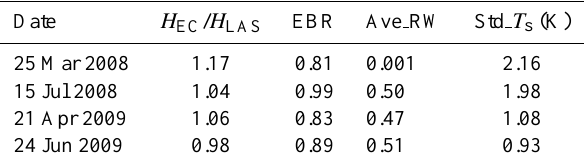
Table 4. Relationships among the differences of the EC and LAS measurements, the energy closure ratio of the EC, the degree of overlap between the source areas of the LAS and EC measurements, and the heterogeneity of the underlying surface at the satellite pass- ing time ( H EC / H LAS : the ratio between the sensible heat fluxes measured by the EC and LAS; EBR: energy balance ratio; Ave RW: the average relative weights of the EC and LAS in the overlapping source area; Std T s : the standard deviation of surface temperature in non-overlapping source